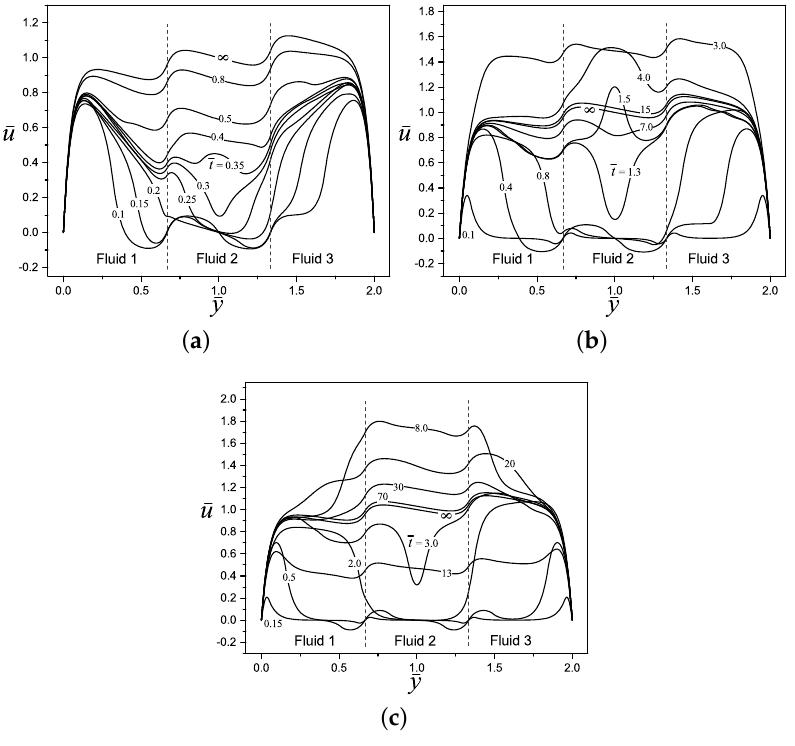
Figure 5. Dimensionless velocity profiles of an electroosmotic flow with n = 3, ( ¯ y 1 = 2/3, ¯ y 2 = 4/3), ¯ κ n = 20, ¯ ρ n = ¯ η n = ¯ (cid:101) n = 1, and ∆ ¯ ψ n = 0.25 for: ( a ) ¯ λ n = 0.1, ( b ) ¯ λ n = 2, and ( c ) ¯ λ n = 10.